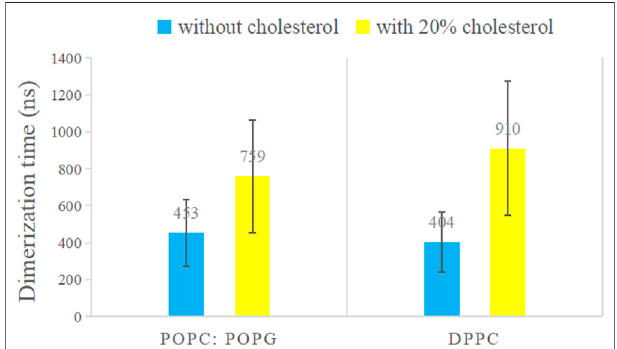
FIGURE 1 | Average dimerization time of C99 dimer in POPC:POPG bilayer and DPPC bilayer with (orange) or without (blue) 20% cholesterol, from theaverageof20samples.Thevaluesarelabeled inthecorrespondingareas. The dimerization time of C99 dimer was calculated based on the center of mass (COM) distance between the C99 monomers. When the COM distance between the two C99 TMDs (transmembrane domains) maintains a levelbelow1 nmcontinuously,wejudgethattheC99monomersformastable dimer.